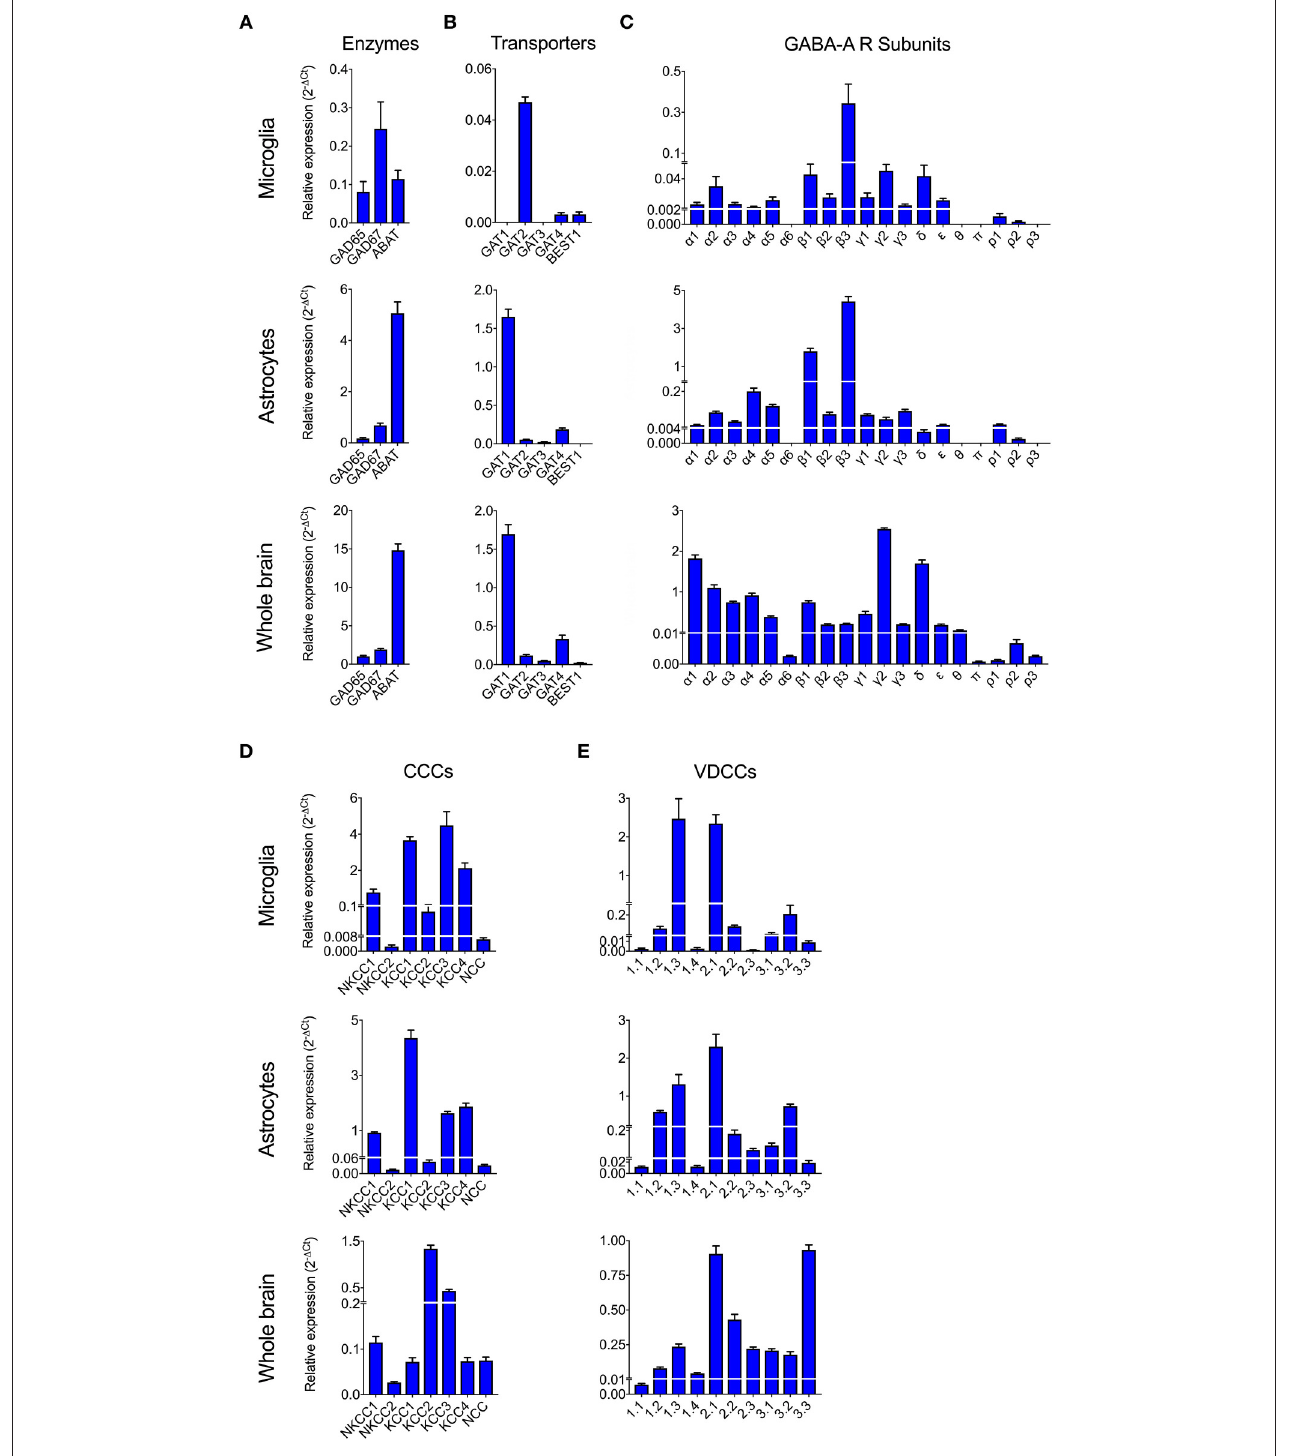
FIGURE 2 | Expression of GABAergic and VDCC signaling components by microglia. The mRNA expression was analyzed by standard qPCR assay as indicated under Materials and Methods. The 1 Ct values for each target were calculated relative to a normalization factor. The relative expression (2 − 1 Ct ) is represented as bar graphs with mean + SEM of 6 independent experiments for microglia, 5 for astrocytes and 4 for brain samples. The mRNA expression levels for (A) GABA synthesis and degrading enzymes, (B) GABA transporters, (C) GABA-A Receptor (R) subunits, (D) Cation Chloride co-transporters (CCCs), and (E) VDCCs are shown in unchallenged primary microglia, astrocytes, and whole